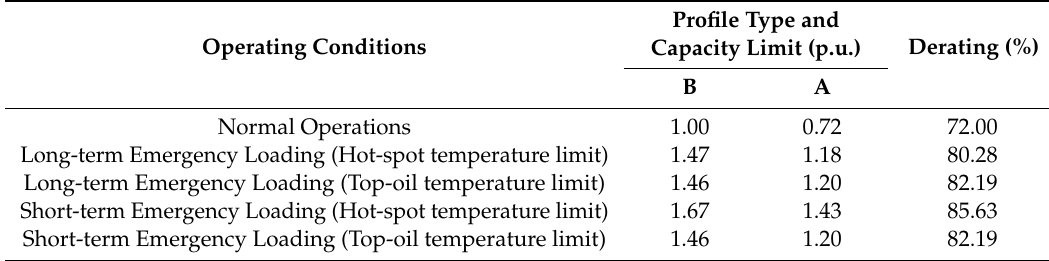
Table 4. Summary of Derating Analysis for THD I =